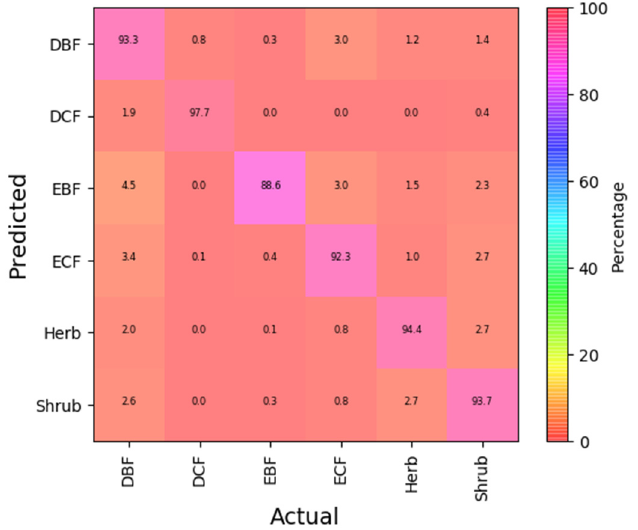
Figure 3. Confusion matrix of the physiognomy level classification of plant communities.